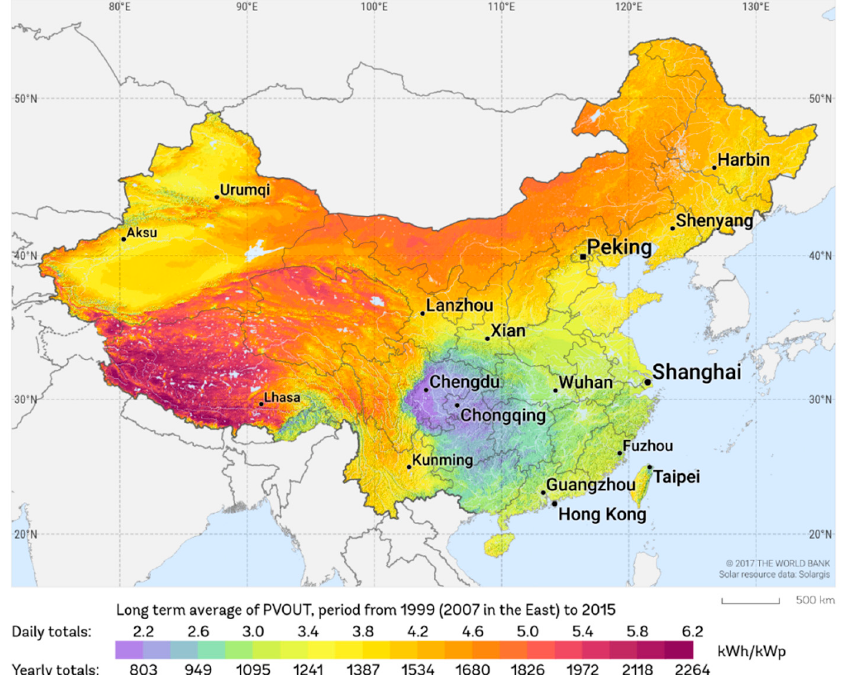
Figure 2. Photovoltaic Electricity Potential Map of China published by The World Bank Group [12].